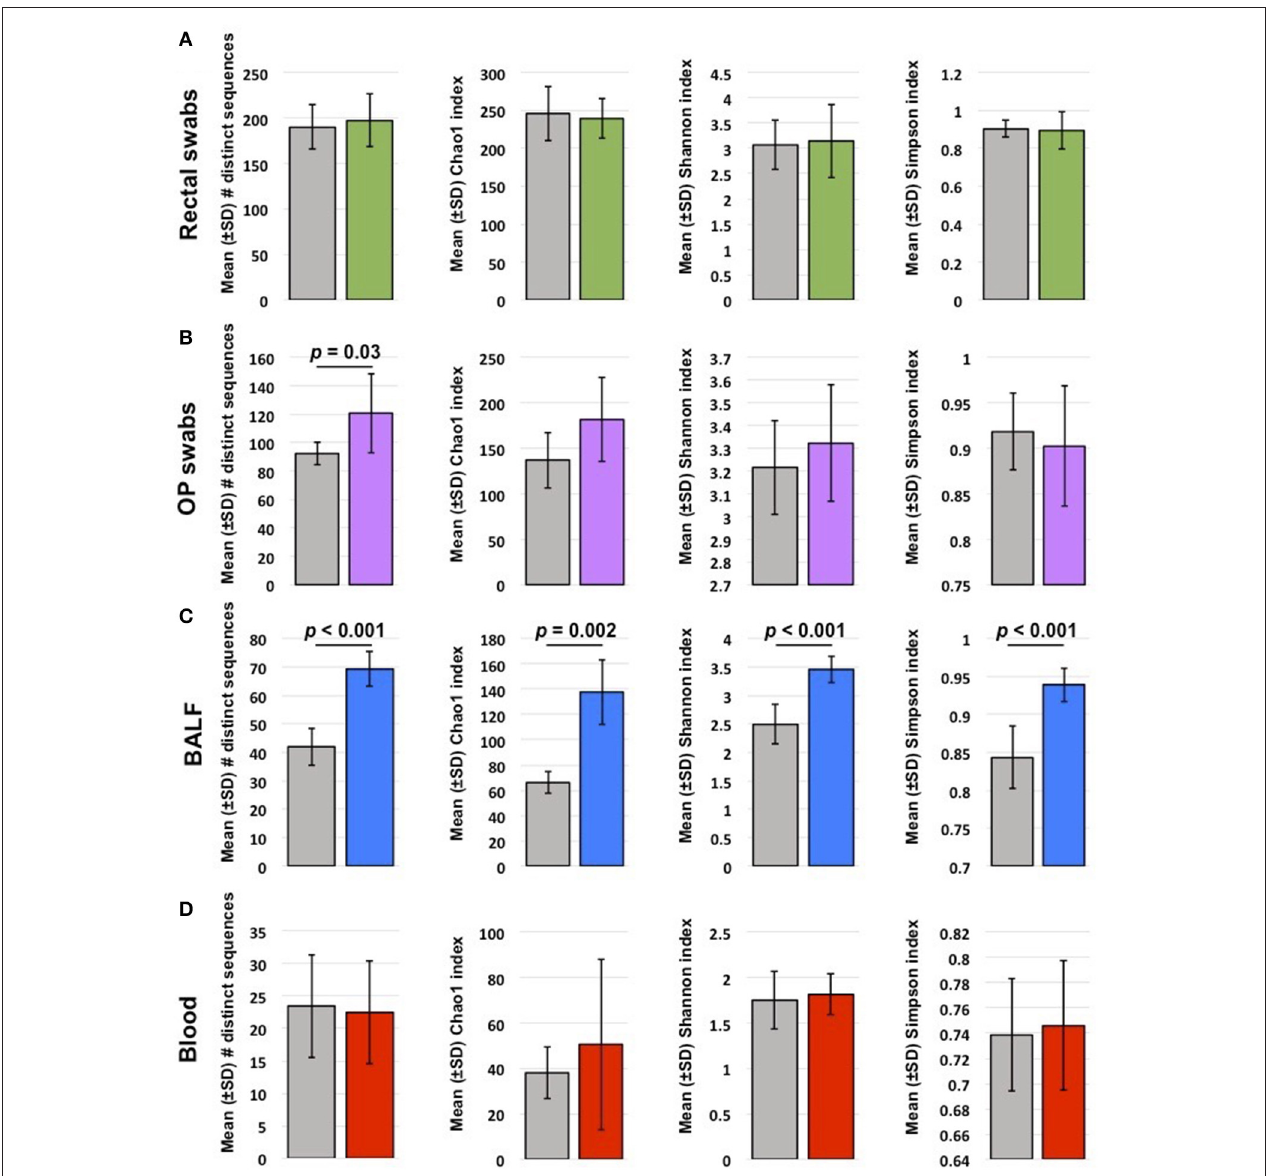
FIGURE 1 | Mean ± standard deviation (SD) richness and diversity of rectal swabs (A) , oropharyngeal (OP) swabs (B) , bronchoalveolar lavage fluid (BALF) (C) , and blood samples (D) collected from 6 healthy young cats at baseline (gray bars) and after probiotic administration (colored bars). Richness is represented by the number of distinct sequences detected and Chao1 index; α -diversity is represented by Shannon and Simpson indices. Significant ( p < 0.05) differences noted above bars ( t -test or Mann-Whitney rank sum test based on